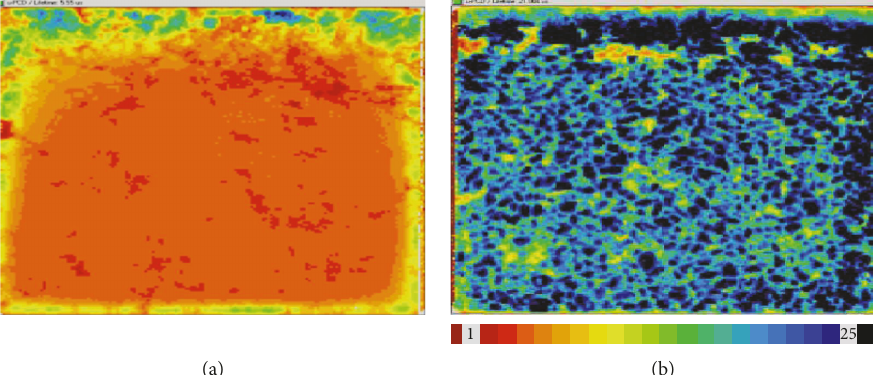
Figure 4: Carrier lifetime maps with respect to time: (a) sample A (without thermal oxidation) average carrier lifetime was 5.5 μ s and (b) sample B (with thermal oxidation) average carrier lifetime was 21 μ s.